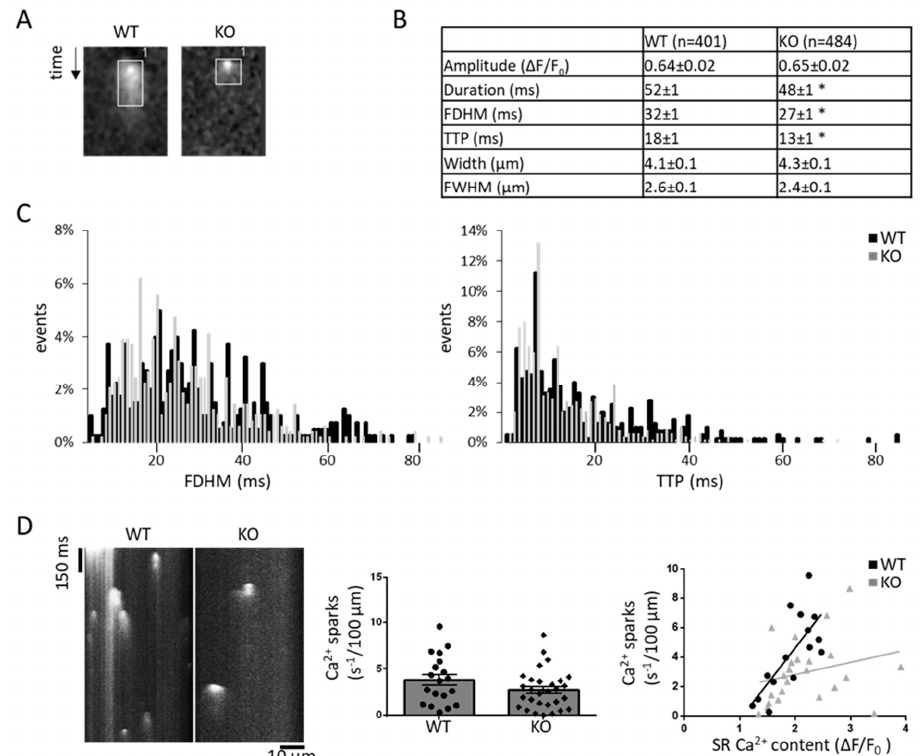
Figure 4. Subcellular Ca 2+ spark properties in a murine model. Example and quantification of Ca 2+ sparks in WT and G q -KO ( A , B ) as well as the distribution ( C ) of full duration at half maximum (FDHM) and time to peak (TTP) in all cells. Example for Ca 2+ sparks in WT (n = 19) and G q -KO (n = 29) and their respective overall frequency without and with correlation to the sarcoplasmic reticulum Ca 2+ content, respectively, (WT n = 15, KO n = 23) ( D ). * p < 0.05 vs. WT. Each data point represents an independent cell preparation and experiment. The total number of animals per group was n = 5 (see Supplementary Figure S1 for per-animal analyses).